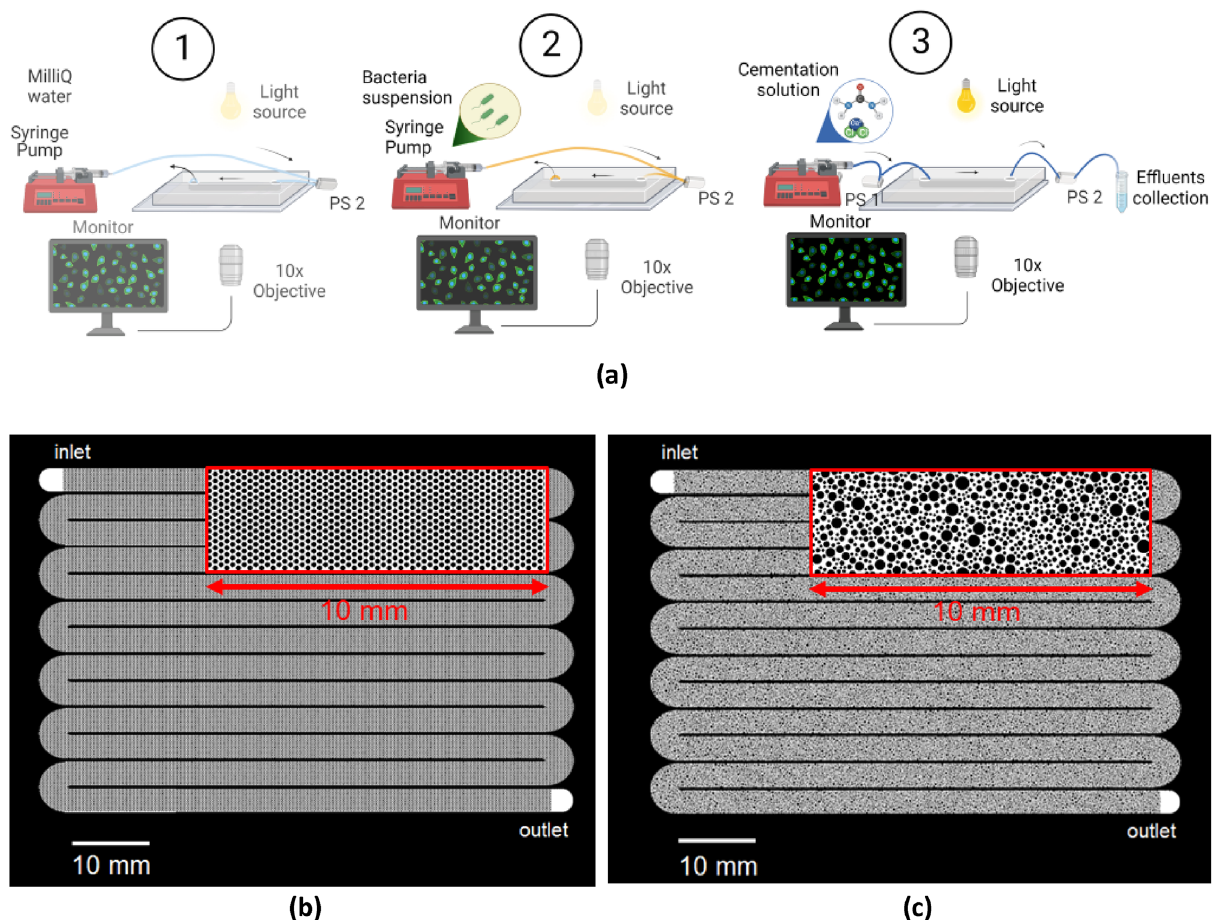
Figure 1. ( a ) Schematic representation of the experimental setup. The injection strategy involves (1) the injection of Milli-Q water from the outlet, (2) the injection of the BS from the outlet and (3) the injection of the CS from the inlet. PS1 and PS2 denote the pressure sensors connected at the inlet and outlet, respectively. Created with BioRender.com; ( b ) microfluidic design of a homogeneous porous medium; ( c ) microfluidic design of a heterogeneous porous